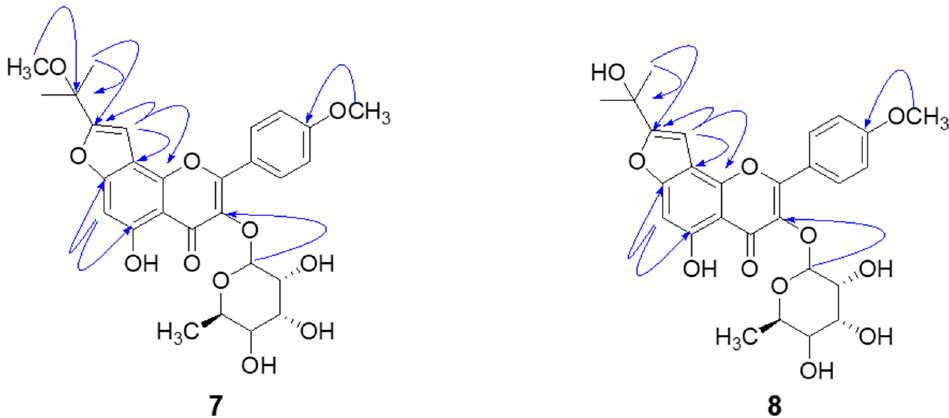
Figure 2. HMBC correlation (H → C) of the new compounds 7 and 8 .